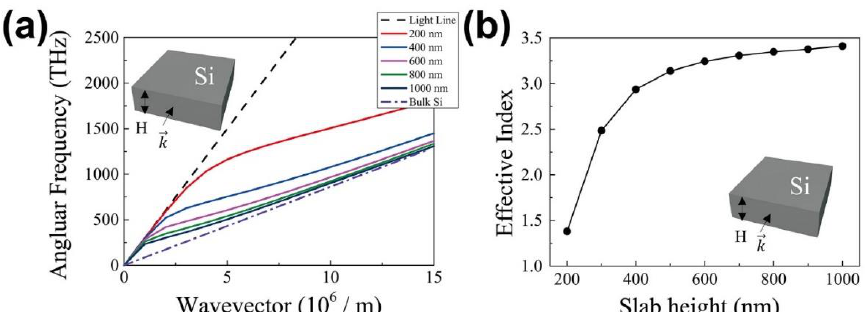
Figure 2. ( a ) Dispersion curves of a transverse magnetic (TM) silicon (Si) slab waveguide mode for different heights ( H ) of the slab, ranging from 200 nm to 1000 nm. The dispersion curve of an infinitely thick Si waveguide mode and light line are indicated by dotted black and blue lines, respectively; ( b ) Effective index of Si slab waveguide mode as a function of slab height ( H ) for the wavelength of 1550 nm.